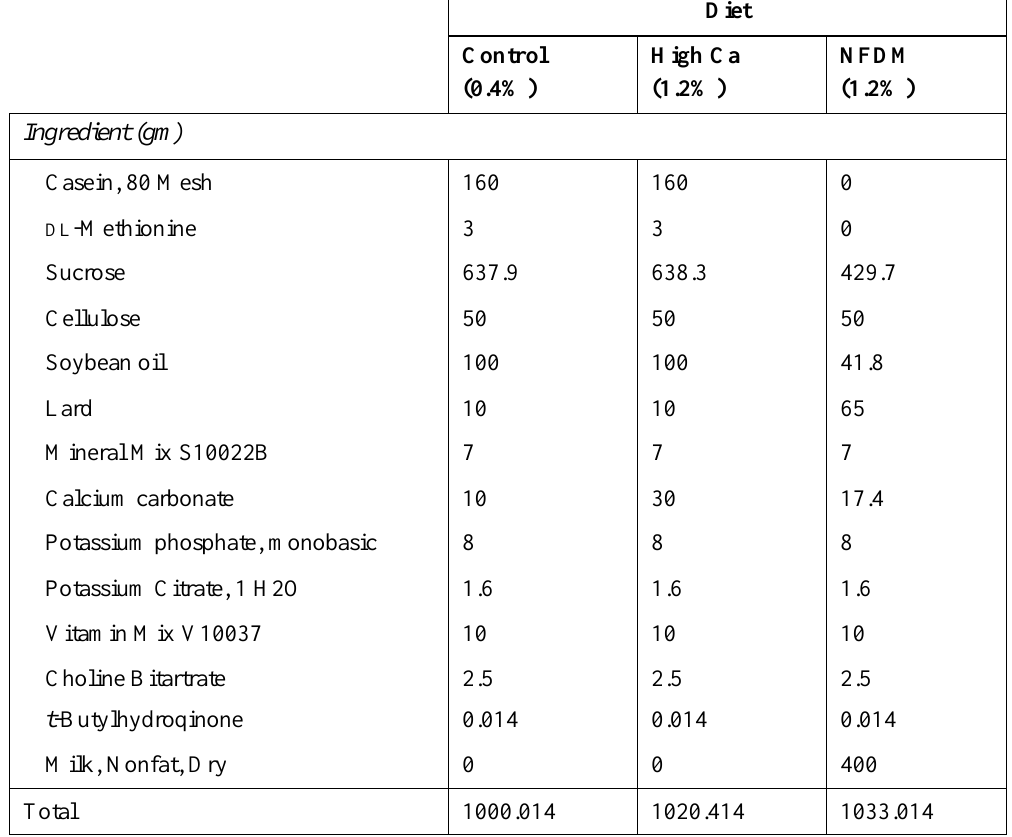
Table 1. Diet composition of the control, high calcium and non-fat dry milk (NFDM) diet groups.